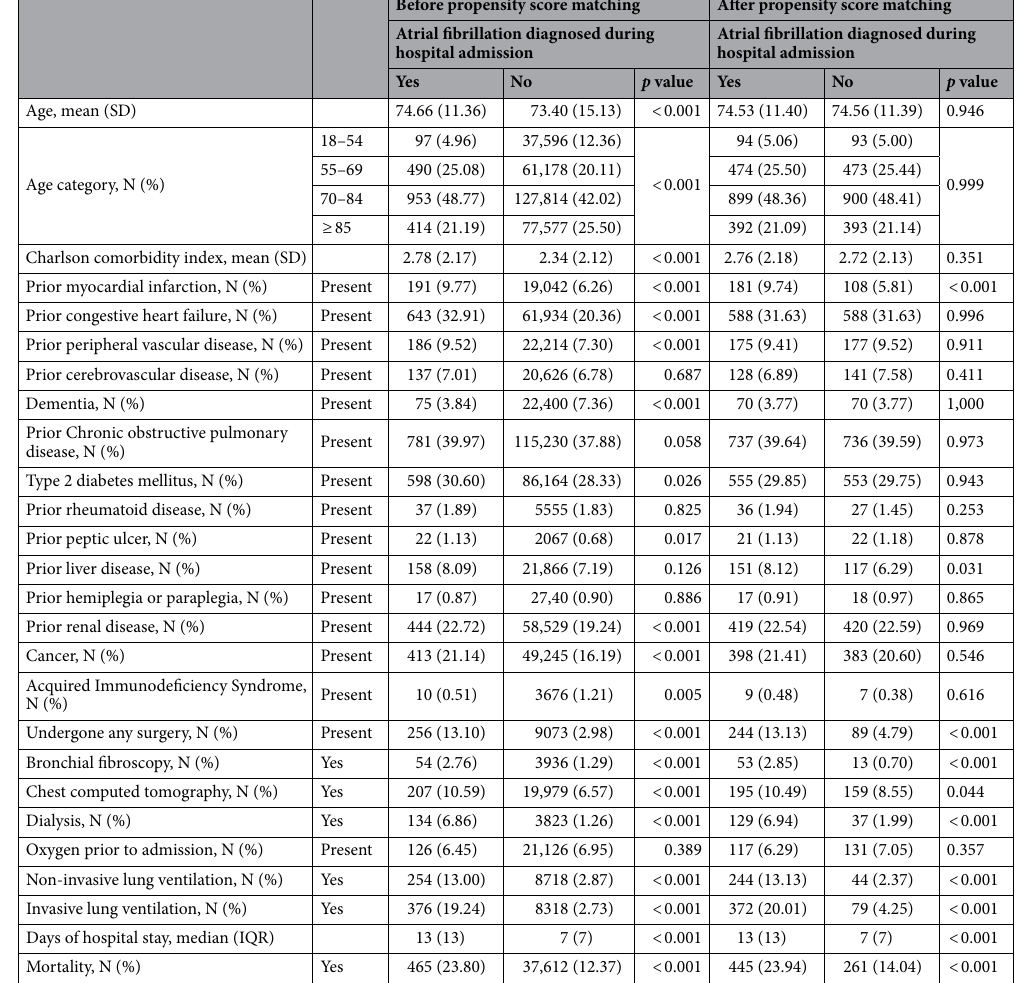
Table 5. Clinical characteristics, and in-hospital outcomes of men hospitalized with community-acquired pneumonia in Spain from 2016 to 2019 according to atrial fibrillation diagnosed during hospital admission, before and after propensity score